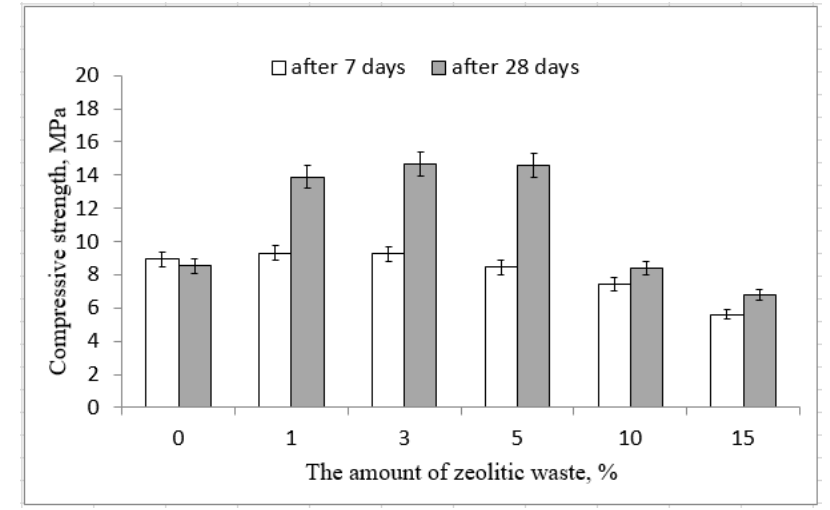
Figure 1. Effect of zeolitic waste on the compressive strength of alkali-activated biomass bottom